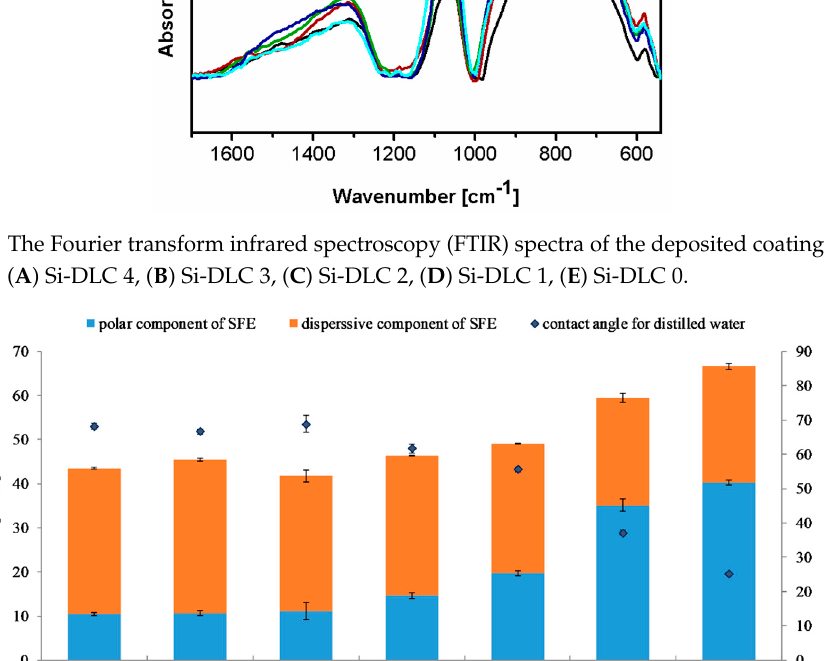
Figure 6. The surface free energy and wettability of the deposited DLC and Si-DLC coatings after sterilization.